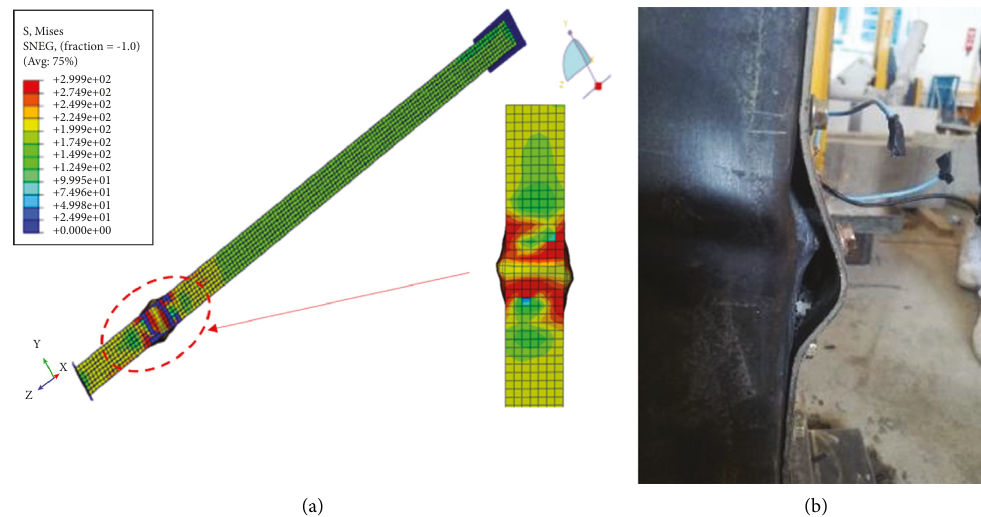
Figure 16: Result comparison of FEM and test for the specimen Z200-2.2-20. (a) FEM result. (b) Test damage.